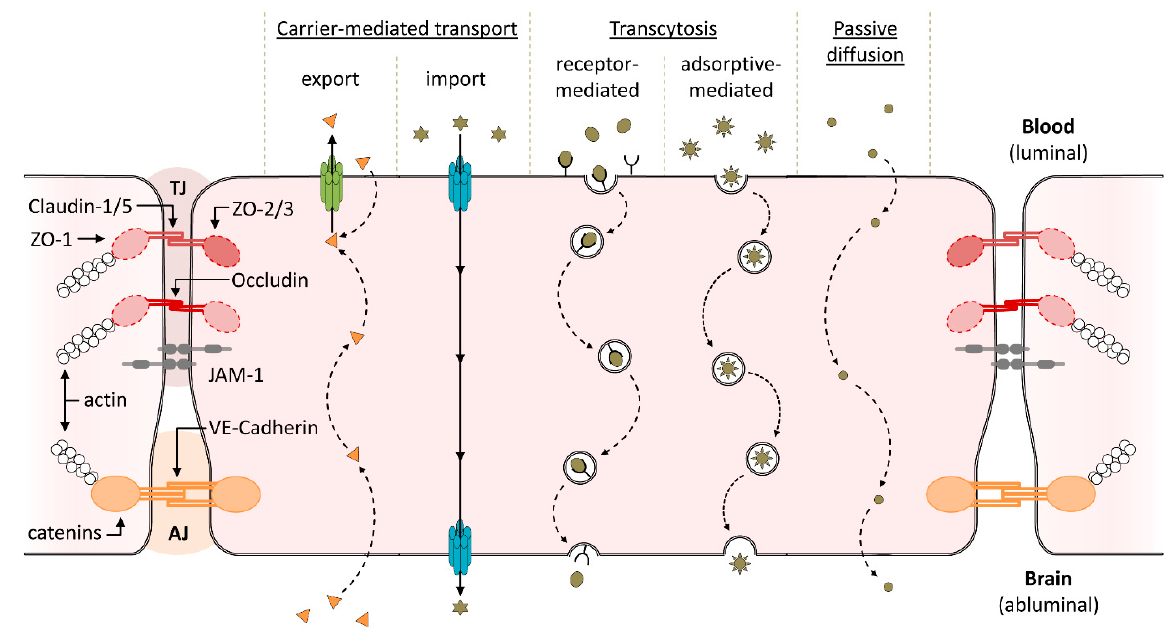
Figure 2. Molecular structure and function of the brain microvascular endothelium. Structural support is provided by adherens junctions (AJ), which are formed by interaction of vascular endothelial (VE)-cadherin from adjacent cells and anchored to the actin cytoskeleton through catenins. The physical barrier function results from tight junctions (TJ), which restrict paracellular permeability and are formed by interaction of claudins, occludin and junctional adhesion molecules like JAM-1 from adjacent cells. Both claudins and occludin are anchored to the actin cytoskeleton through membrane-associated zonula occludens (ZO) proteins. The transport barrier function results from export of lipophilic xenobiotics and drugs (orange triangles) by efflux transporters (indicated in green) present in the luminal (i.e., blood-sided) membrane. Transfer of nutrients and other compounds into the brain depends on their physicochemical and/or biological properties and can occur through carrier-mediated import, receptor- or adsorptive-mediated transcytosis or passive diffusion. Finally, intracellular metabolic enzymes (not shown) can metabolize compounds on their way into the brain, conferring the endothelium with an additional, metabolic barrier function.